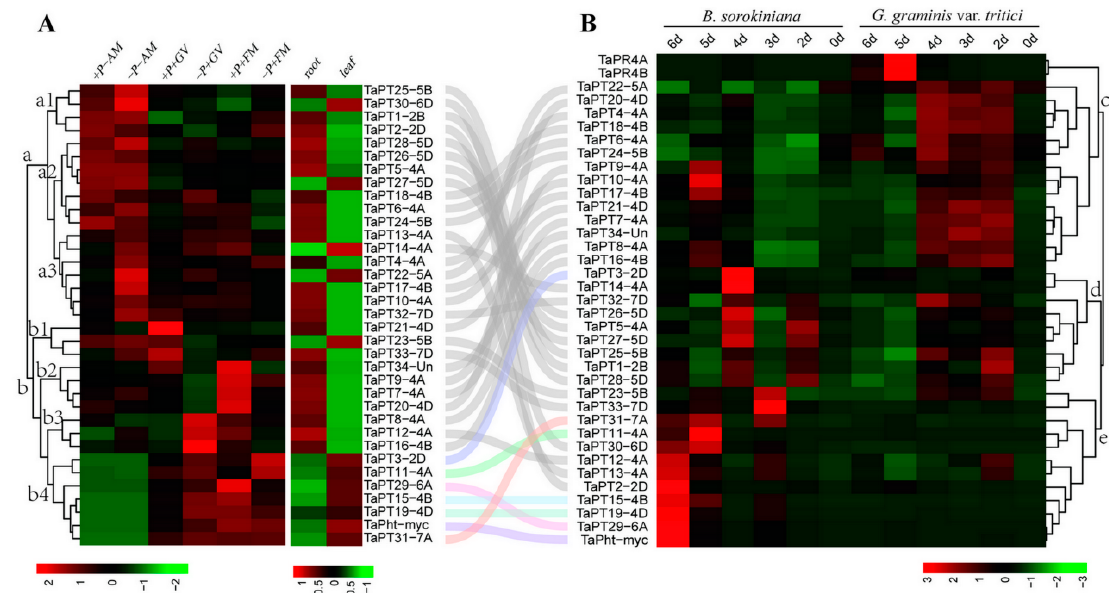
Figure 4. Expression profiles of 35 TaPHT1s under indicated treatments. ( A ) TaPHT1s expression patterns in roots colonized with two varieties of AM fungi after six weeks in high and low phosphorus conditions (left panel); TaPHT1 genes’ expression patterns in roots and leaves of non-symbiotic 6-weeks-old seedlings (right panel). ( B ) TaPHT1s expression patterns in roots infected by Ggt and B. sorokiniana at 0–6 dpi.